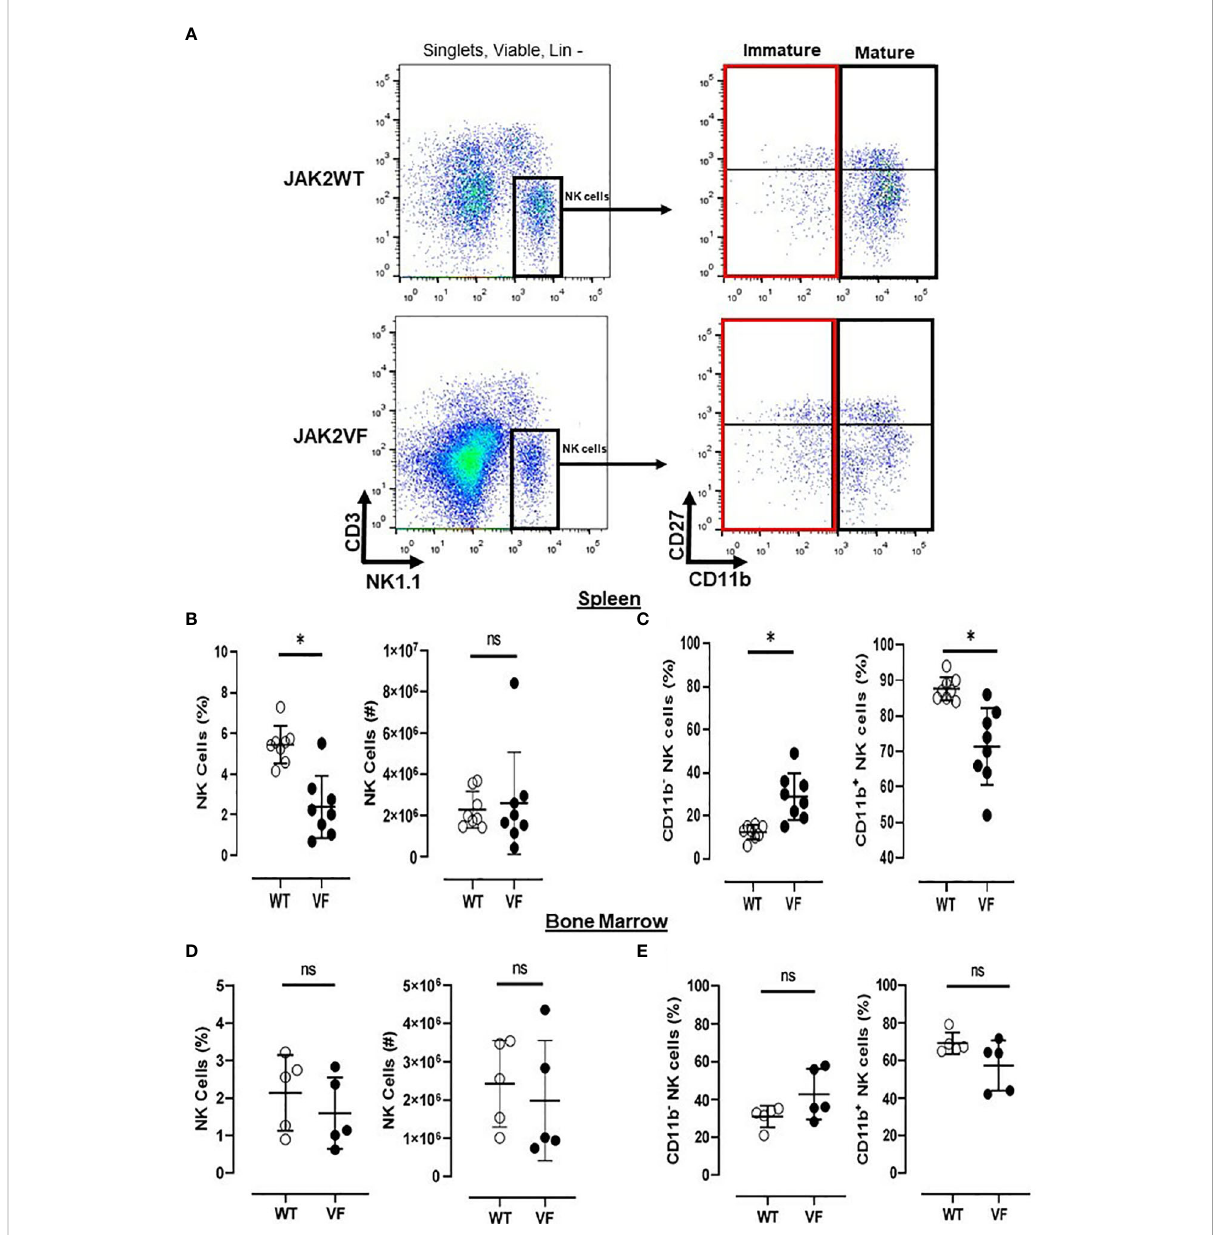
FIGURE 1 Mature NK cells are low numbered in Jak2V617F mice. (A) Gating strategy to characterize NK cells (Lin neg( − ) [TER119 − /CD4 − /CD8 − /CD19 − ] CD3 − NK1.1 + ) and their maturational subsets, in myeloproliferative neoplasms with JAK2V617F mutation (VF) or not (WT), de fi ned as mature (CD27 − CD11b + and CD27 + CD11b + ) and immature (CD27 − CD11b − and CD27 + CD11b − ) NK cells. Frequency and absolute numbers of NK cells in (B) spleen and (D) bone marrow. Frequency of immature (CD11b − ) and mature (CD11b + ) NK cells in (C) spleen and (E) bone marrow. VF, JAK2V617F mutated (n = 13); WT, JAK2 wild-type (n = 13). Error bars indicate the mean (± SEM). NS, not signi fi cant (p > 0.05); *p < 0.05; Mann – Whitney